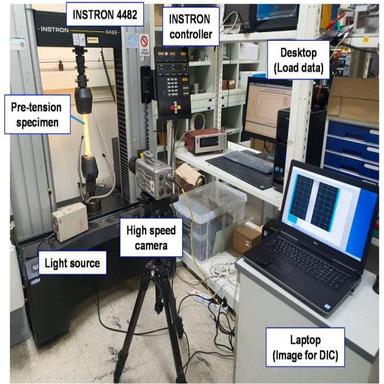
Experimental setup for a uniaxial tensile test using a large-sized tensile specimen.